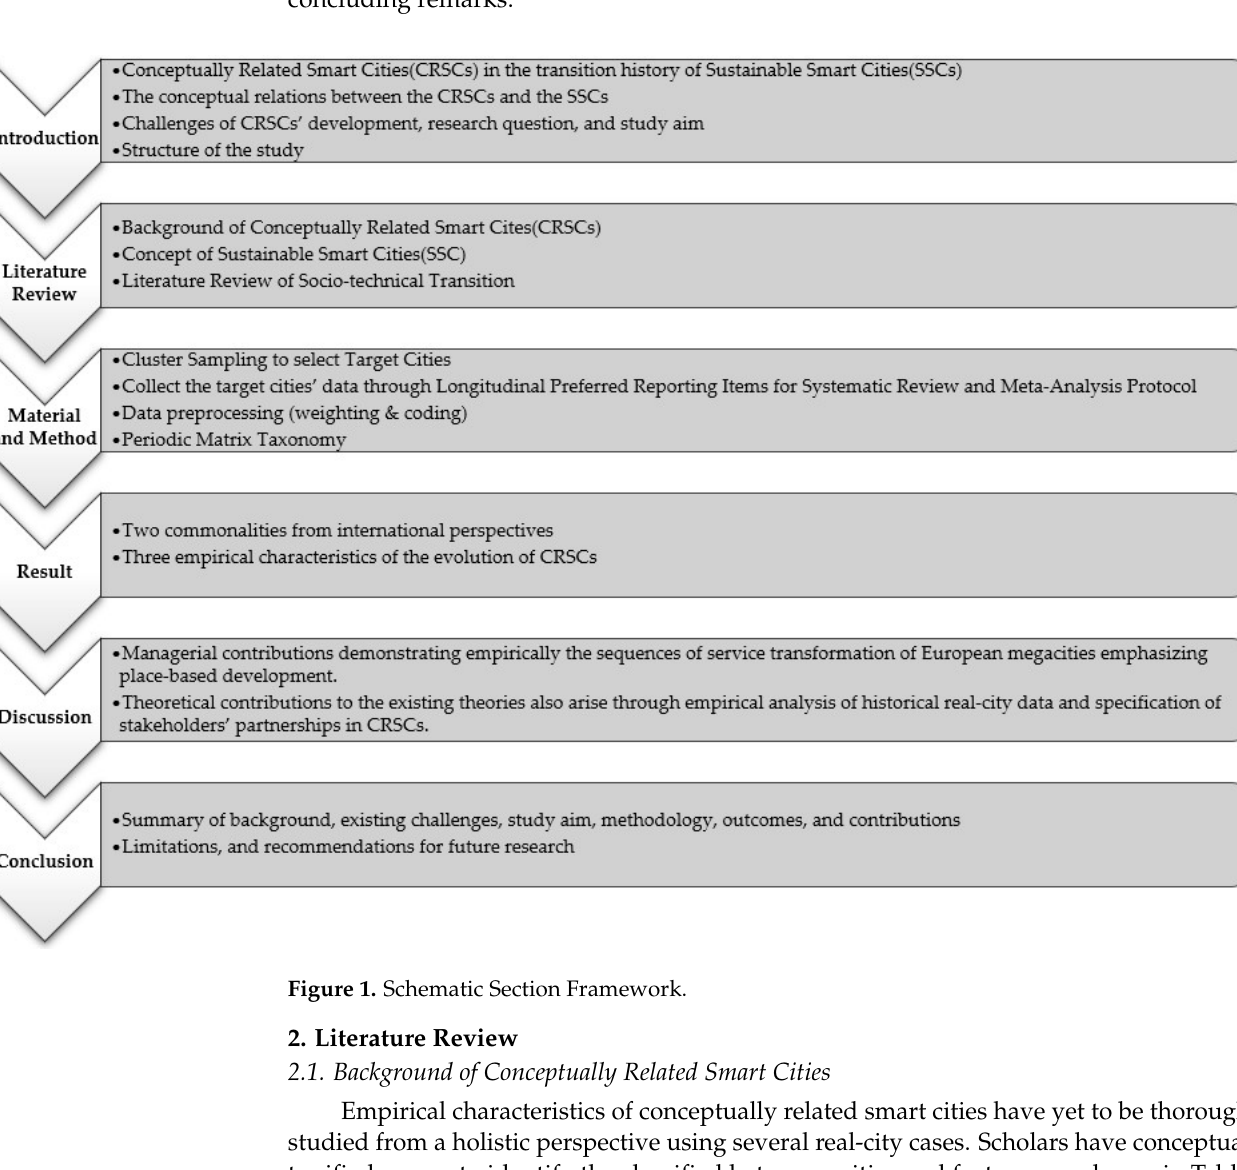
Figure 1. Schematic Section Framework.